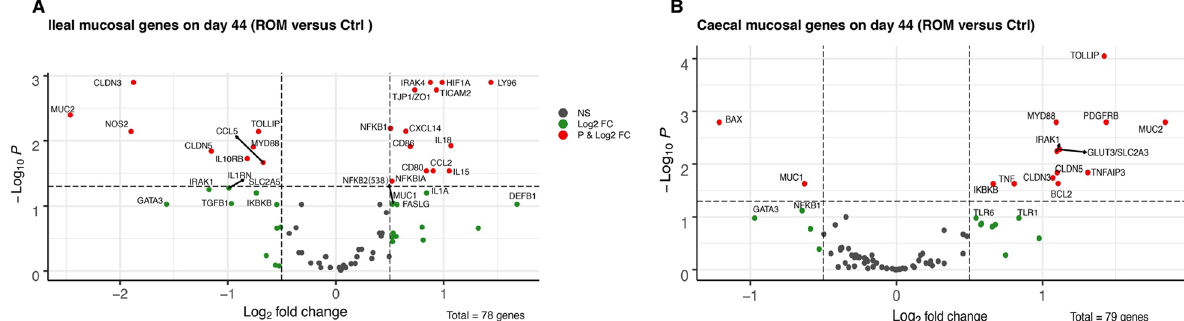
Fig. 7 Volcano plots of genes expressed in ileal ( A ) and caecal ( B ) mucosa on day 44, respectively. The x‑axis is the log2 fold change (log2 FC) for the ratio ROM treatment versus Ctrl group and the y‑axis is the log10 p value that was adjusted by “FDR” for multiple testing. The red dots − represent genes that were either significantly more (positive fold‑change) or less (negative fold‑change) expressed in the ROM group as compared to the Ctrl group, with adjusted p 0.05 and a log2 FC > 0.5. Green points indicate differentially expressed genes with adjusted p > 0.05 and a log2 ≤ FC >